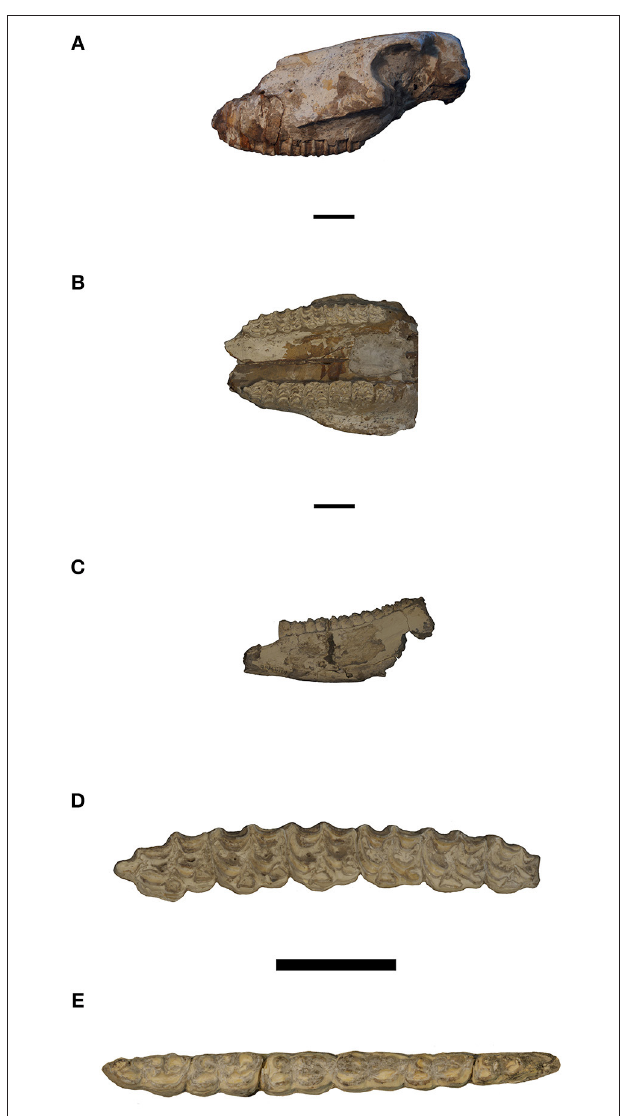
FIGURE 7 | Dmanisi Equus . (A) Skull in lateral view; (B) Skull in ventral view; (C) Mandible in lateral view; (D) Upper tooth row in occlusal view; (E) Lower tooth row in occlusal